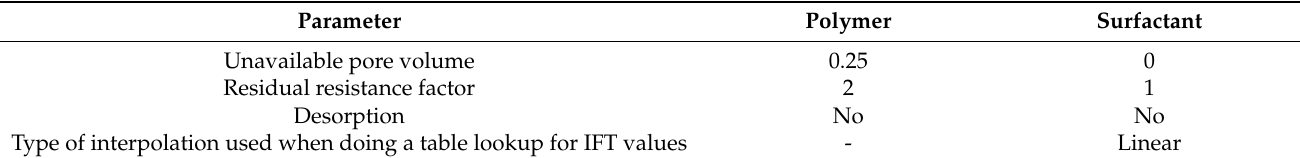
Figure 8. Adsorption concentration curve for surfactants. Table 2. Values of parameters for the simulation to